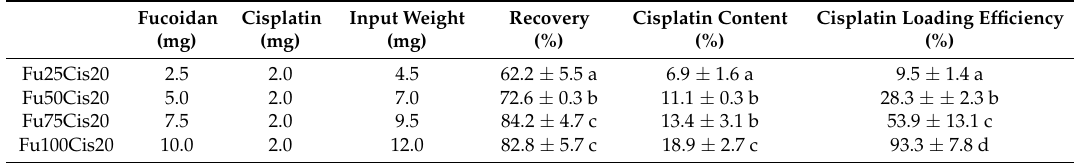
Table 1. Recovery, cisplatin content and cisplatin loading efficiency of fucoidan-cisplatin nanoparticles by 2 mg cisplatin mixing with different weights of fucoidan.